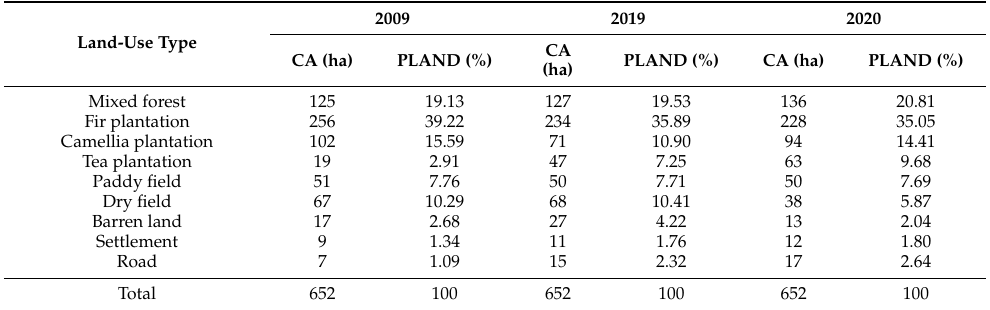
Table 6. Total area coverage between 2009 and 2020 for the classified land-use types. CA: total (class) area; PLAND: percentage of landscape.